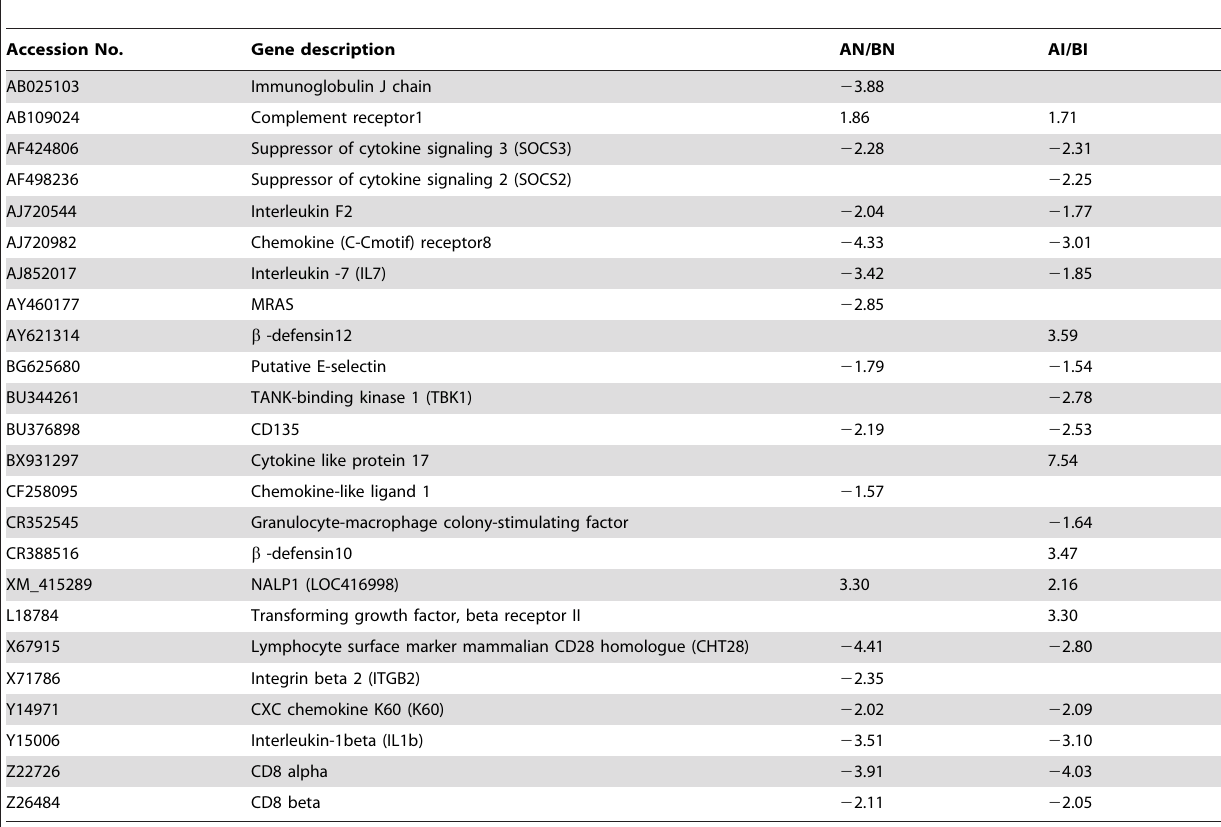
Table 1. Fold-change of significantly differentially expressed immune-related genes between genetic lines in the microarray results ( P , 0.01).